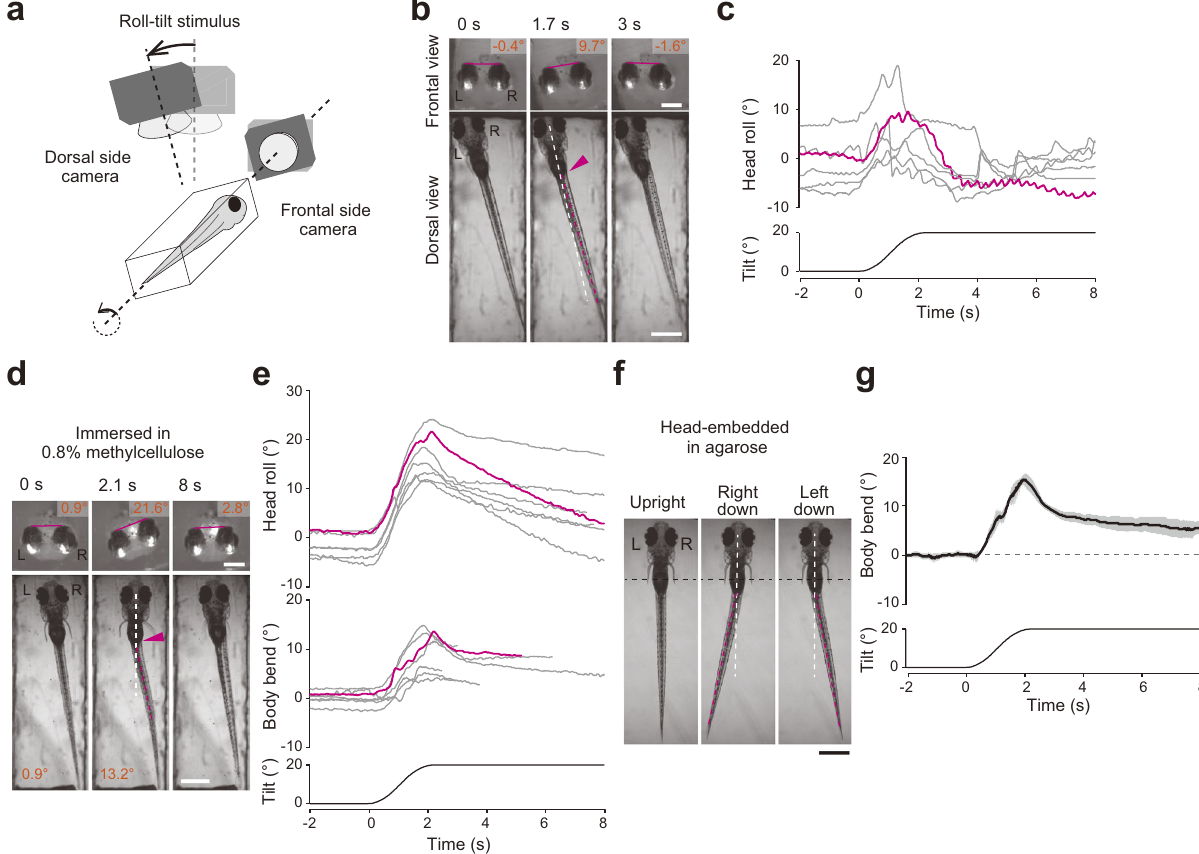
Fig.1|Larval fi shperformthevestibular-inducedbendre fl ex(VBR)duringroll tilt. a Schematic illustration of the behavioral imaging. b Snapshots of the fi sh during a left-downtilt. The frontalimagesare horizontally fl ipped(mirror-imaged) such that the left – right relationship matches with that of the dorsal images. The bars in thefrontalimagesshowthelinesconnectingthetopsof the eyes. Head-roll angles are indicated at the top. The white dashed line denotes the midline of the rostralregion of the fi sh. The magenta dashedline denotes the line connecting the caudalendoftheswimbladderandthetailend.Themagentaarrowheadindicatesa bodybend.Thedorsalviewofthe fi shbecameobliquewhenthe fi shrecoveredthe posture (3s) due to rotation of the dorsal side camera. c Time course of the head rollanglesinresponsetotiltstimuli.Sixtrialsina fi shareshown.Themagentatrace corresponds to the trialshownin b . d , e Same as b and c , except fi sh were inwater